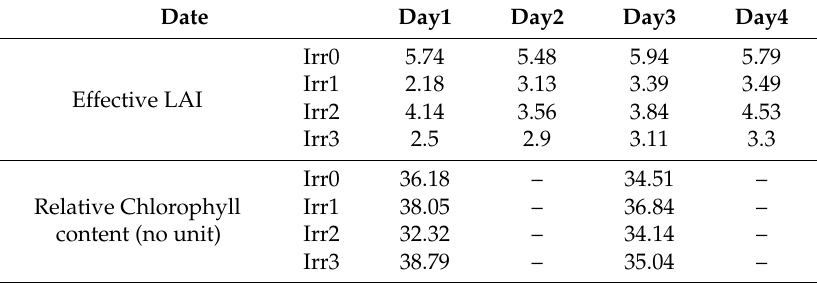
Table 2. Leaf area index (LAI) values and chlorophyll contents of every plot during the experiment. Effective LAI values were estimated using the measurements of AccuPAR LP-80 at 10